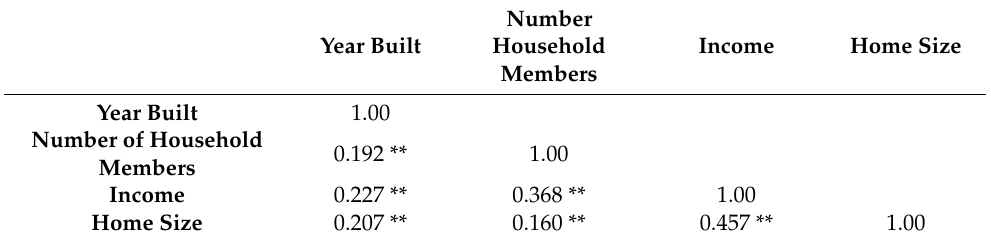
Table 8. Correlation analysis—Mixed-Humid Climate (Spearman’s ρ